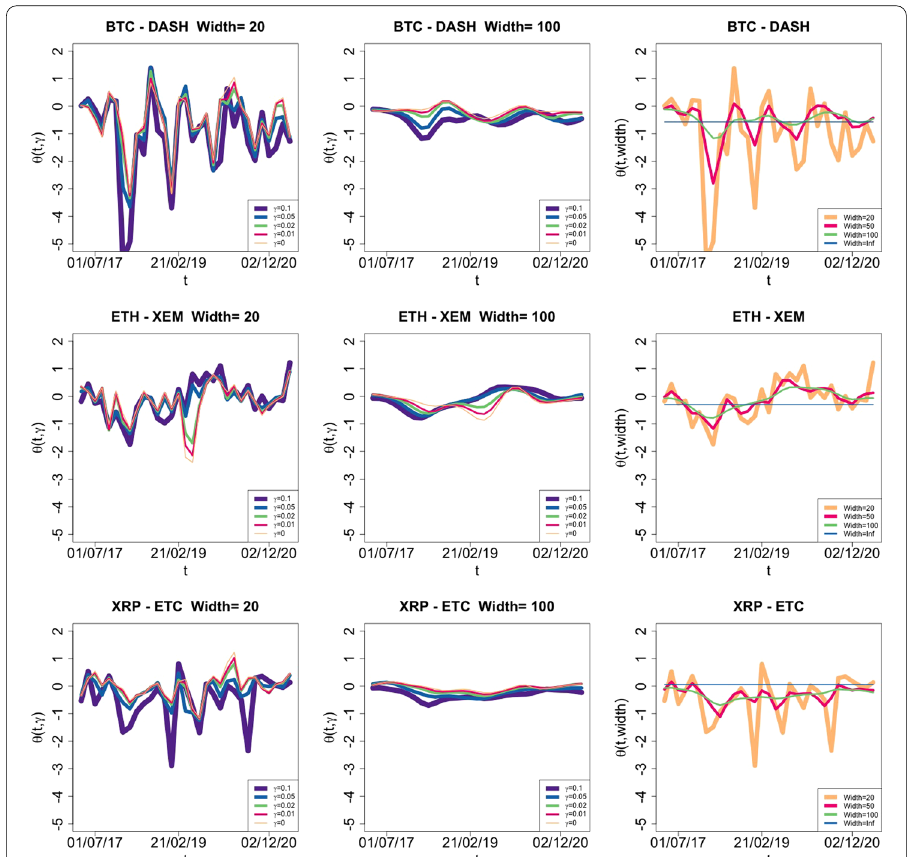
Fig. 10 The plots show the dynamics of the conditional correlation between the 2 CCs reported in the title. In the first two column the value of the bandwidth is fixed at h = 20 and h = 100 respectively and each line in the plot corresponds to a parameter γ as detailed in the legend. In the third column the value of gamma is fixed at γ = 0.1 and each line in the plot corresponds to a bandwidth parameter h as detailed in the